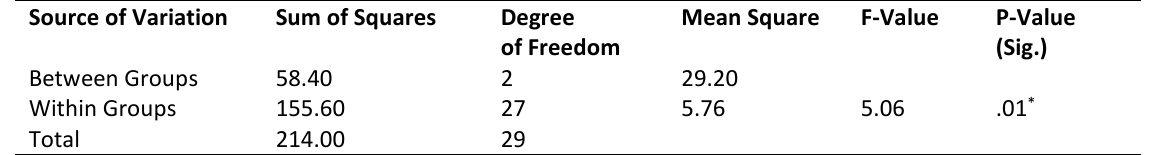
Table 17. One way analysis of variance (Anova) results among judo, taekwondo and boxing players with regard to the sub-parameter coach Source of Variation Sum of Squares Degree Between Groups 58.40 2 29.20